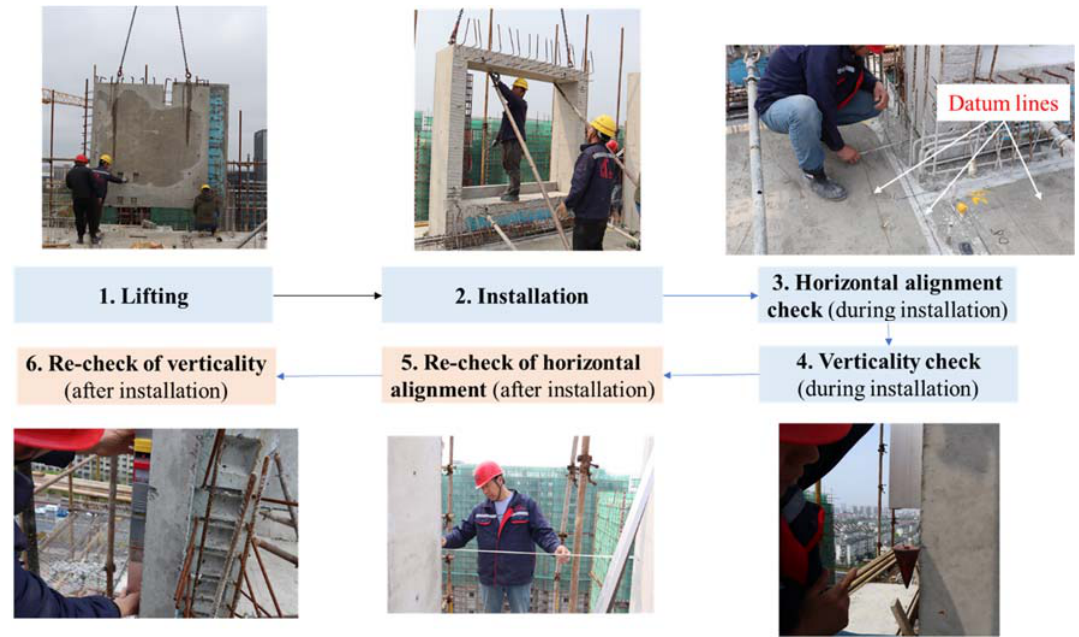
Figure 1. Installation and quality check procedures of PWPs on site.